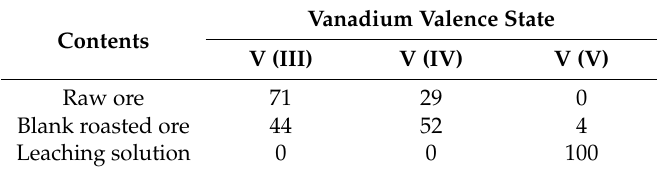
Table 3. Vanadium valence states analysis of raw ore, blank roasted ore and leaching solution wt %.